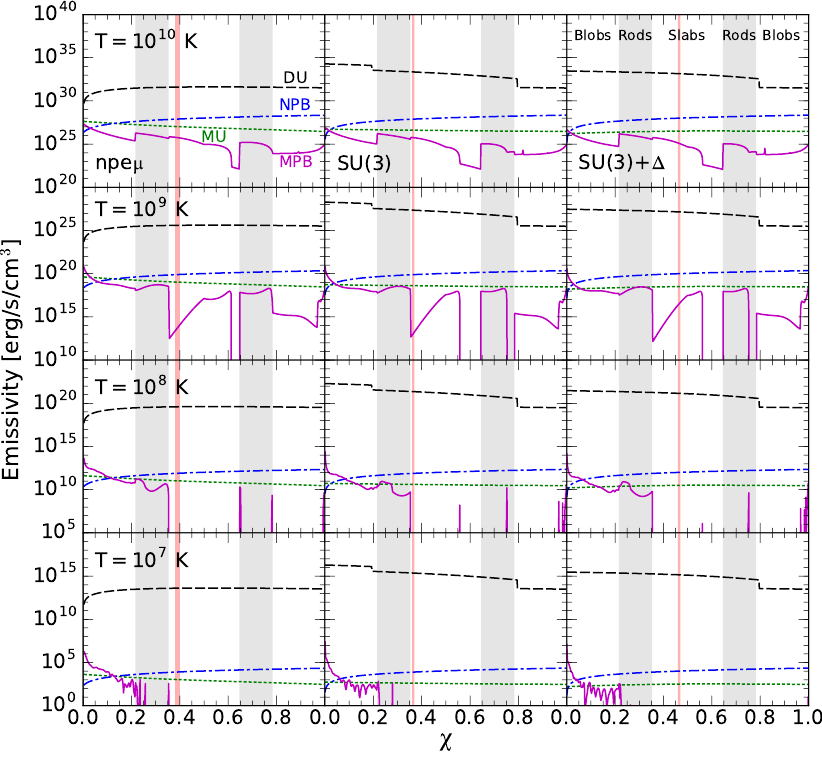
Figure 7. Neutrino emissivity in the quark–hadron mixed phase for the DD2 parametrization with G V = 0.05 G S [7]. Contributions due to mixed phase Bremsstrahlung (MPB), nucleon–nucleon and quark–quark neutrino pair Bremsstrahlung (NPB), the nucleon and quark modified Urca processes (MU), and the hyperon and quark direct Urca (DU) processes are included. See Figure 2 for additional details. Similar figures for the SWL, GM1L, and ME2 parametrizations can be found in